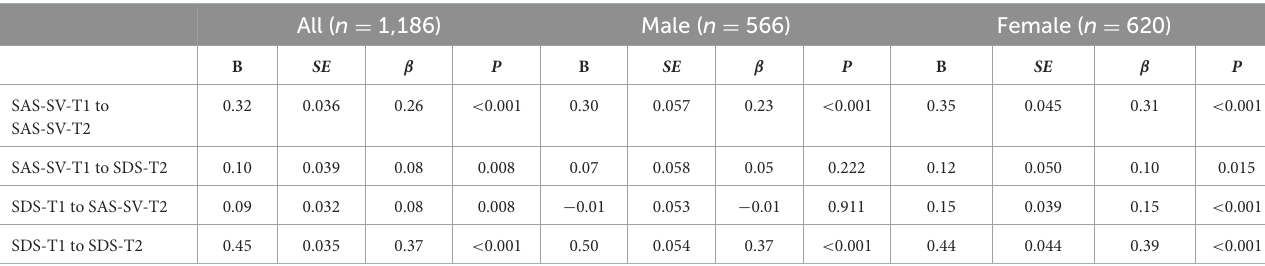
SE, Standard error; T1 = assessed at baseline, T2 = assessed at follow-up. SAS-SV, Smartphone Addiction Scale-Short Version; SDS, Zung’s Self-Rating Depression Scale. Standardized coefficients